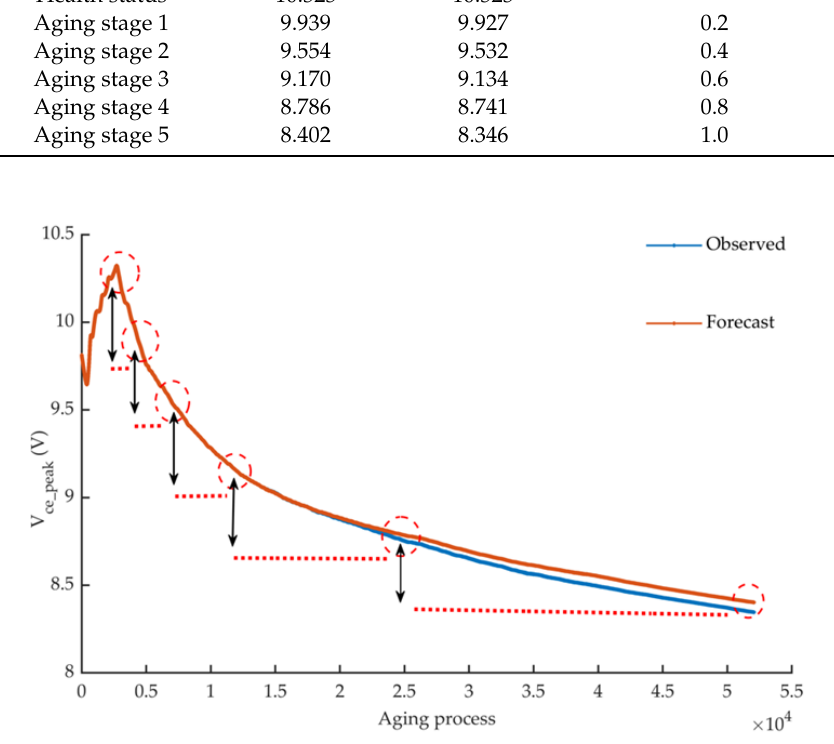
Figure 10. IGBT aging